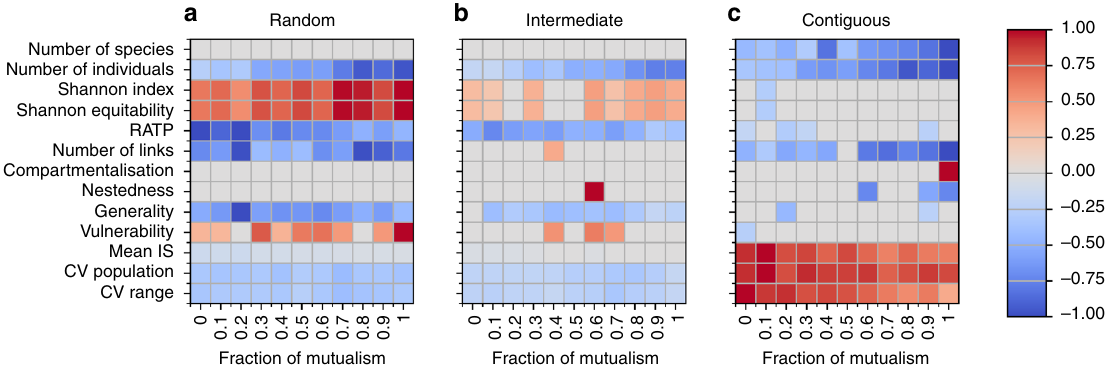
Fig. 1 Response of community metrics to habitat loss. Summary of signi fi cant linear trends in the response variables under a random, b intermediate, and c contiguous HL, are shown for different fractions of mutualism. Red and blue squares represent signi fi cant (at p ≤ 0.05; F-test) positive and negative linear trends, respectively, while grey indicates the absence of a signi fi cant trend. The shade of the red/blue indicates the size of trend detected, as shown in the colour bar. Trend size is normalized within each row, such that the colour indicates the effect size for each response variable relative to different fractions of mutualism (normalization was performed by setting the maximum value of each row to 1). This should be noted for the number of species, which, despite it decreases signi fi cantly under contiguous HL, the largest effect size detected corresponds to an average loss of ∼ 0.5 species across the HL gradient. Therefore, all species can be considered to persist in the